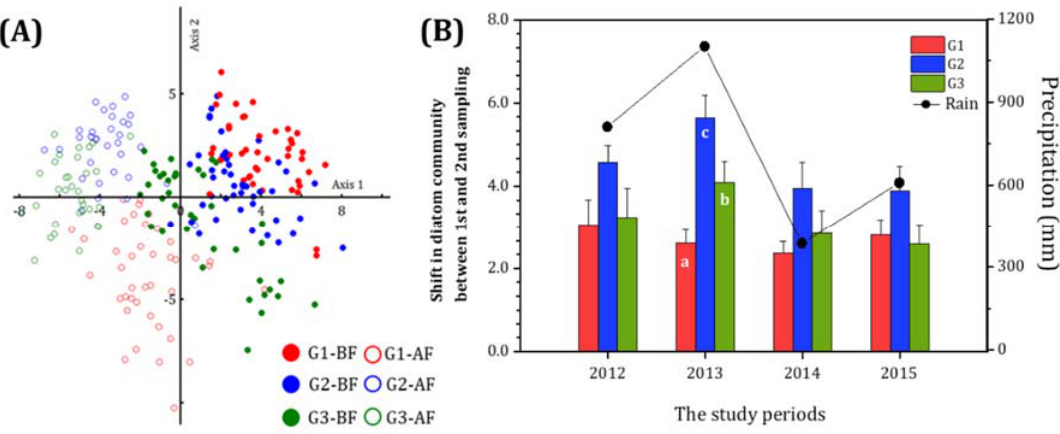
Figure 6. Epilithic diatom community characteristics before and after monsoon in the Hantangang River from 2012 to 2015, including ( A ) the PCA ordination and ( B ) the CDI or average of distances of each group between the before (1-BF) and after monsoon (2-AF) period. Black circle is total annual precipitation during the monsoon period every year. Example, G1-BF and G1-AF: the sampling sites of group 1(G1) before (red-closed circle) and after monsoon (red-open circle), respectively.